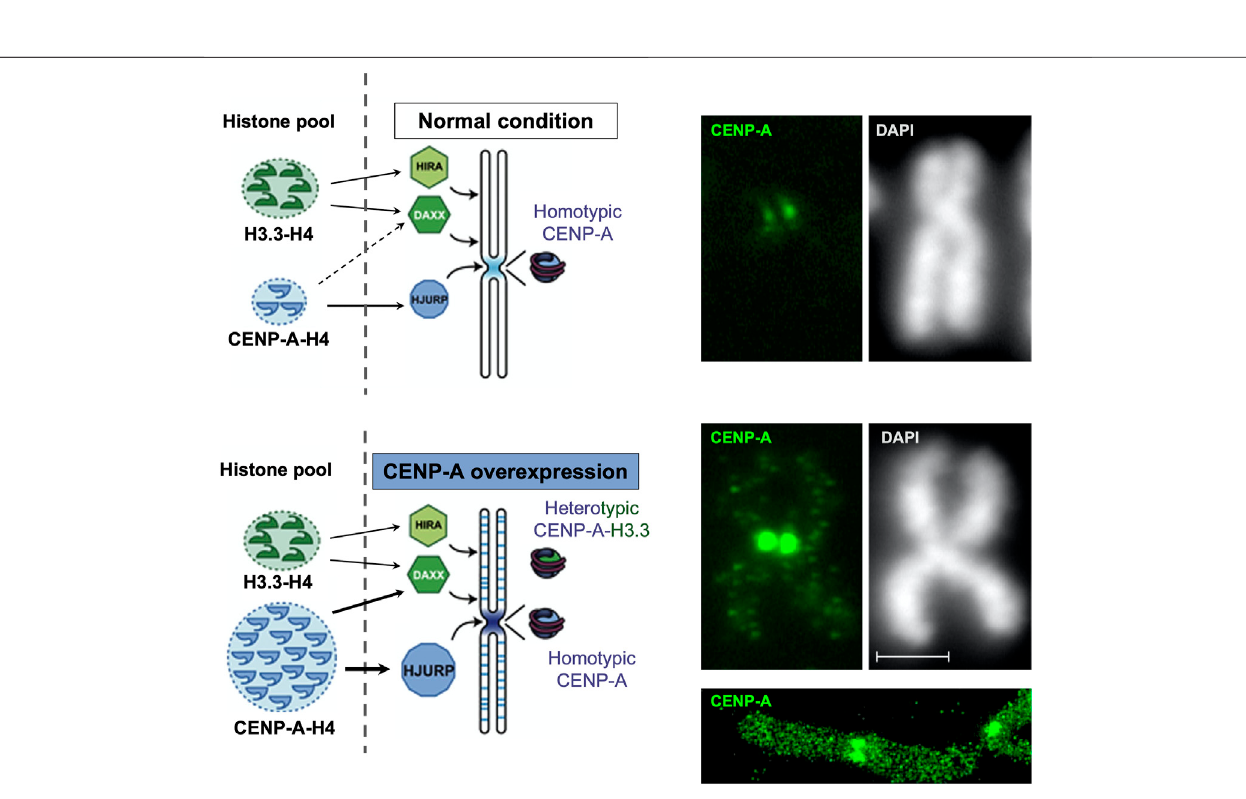
FIGURE 3 | CENP-A overexpression leads to a mislocalization to chromosome arms with formation of heterotypic nucleosomes. Modi fi ed from Lacoste et al., 2014 . Left,scheme:inthe normalsituation(top), CENP-A isdeposited speci fi cally at thecentromere byits dedicatedchaperone HJURP and formshomotypicparticles. Upon overexpression (bottom), CENP-A get mislocalized in the chromosome arms in a manner that depends on a H3.3 chaperone, DAXX. In these loci, the CENP-A particle is heterotypic. Right, immuno fl uorescence images for CENP-A detection on a mitotic chromosome compare normal (top) and CENP-A overexpressing (bottom) HeLa cells along with a DAPI staining. Scale bar = 2 μ M. Below, a super-resolution image (courtesy of Tristan Piolot and Nicolas Lacoste) further illustrates the mislocalized CENP-A in chromosome arms.